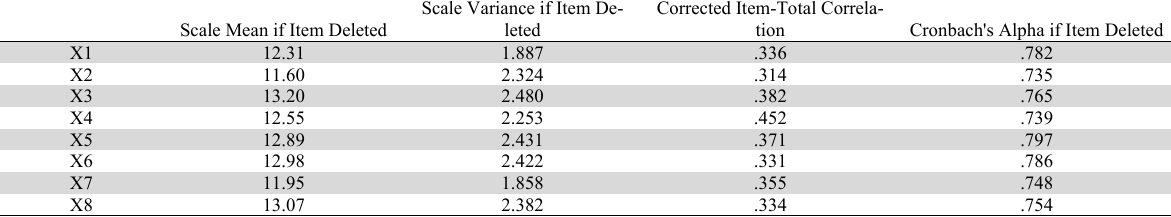
Results of Cronbach’s Alpha Testing of